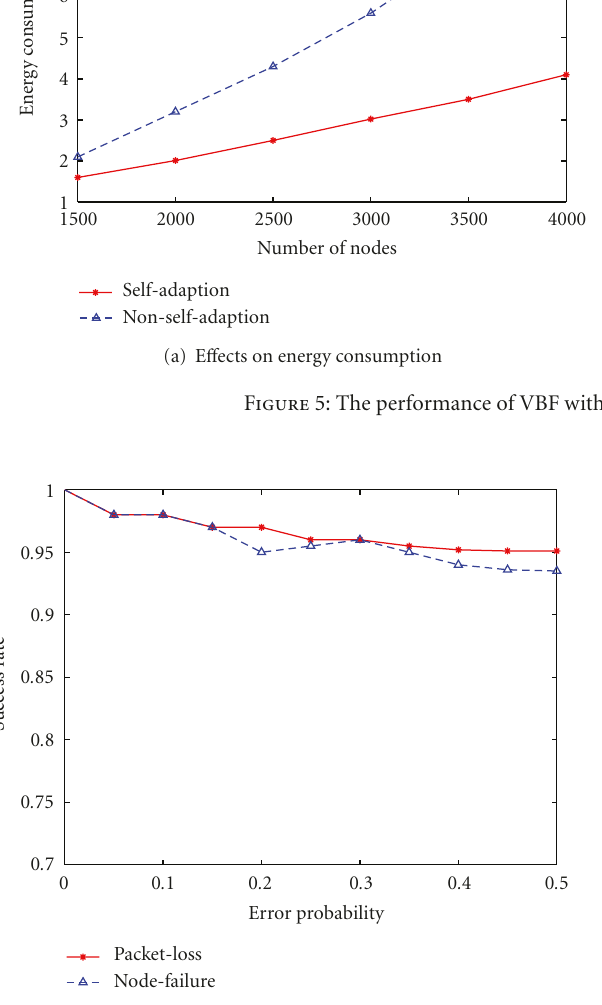
Figure 6: The performance of VBF with varying packet loss and node